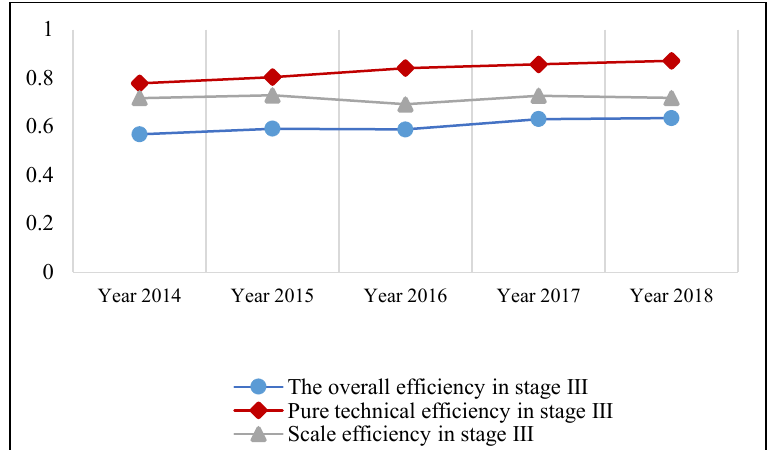
The overall efficiency in stage Ⅲ Pure technical efficiency in stage Ⅲ Scale efficiency in stage Ⅲ Figure 1. The average efficiency of China's major coastal ports (2014 – 2018). Figure 1. The average efficiency of China’s major coastal ports (2014–2018).